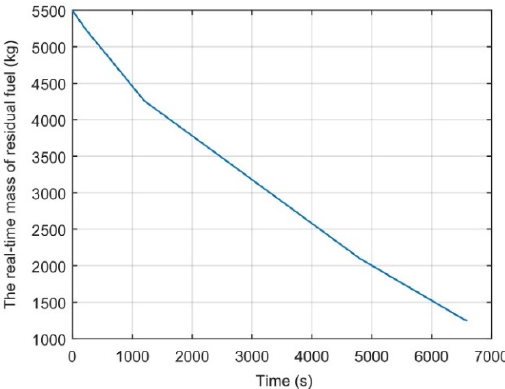
Figure 16. The mass of residual fuel inside unilateral fuel tank.